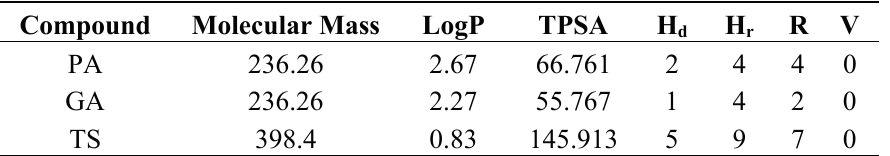
Table 3. Molecular properties of PA, GA and